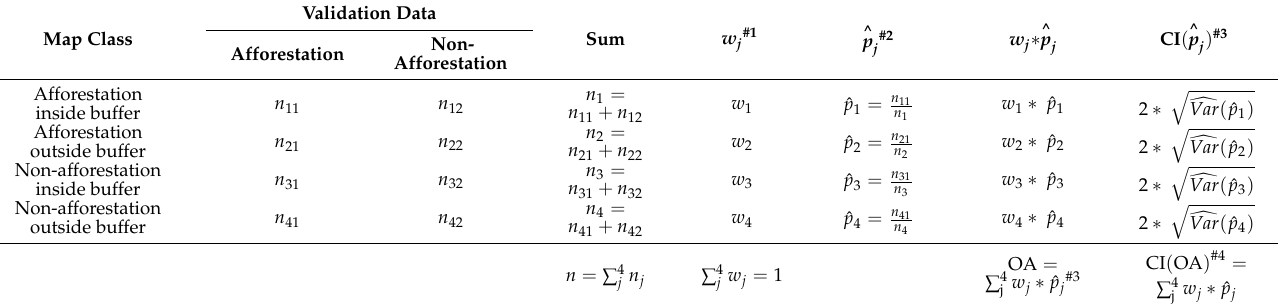
Table 3. Accuracy assessment for direct map.